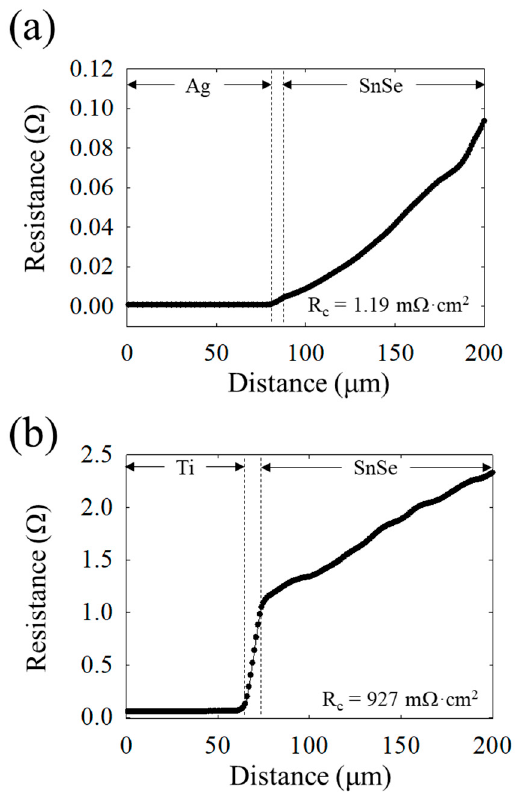
Figure 3. The graphs of SCR (Specific Contact Resistance) of ( a ) Ag and ( b ) Ti single-layer metallization.